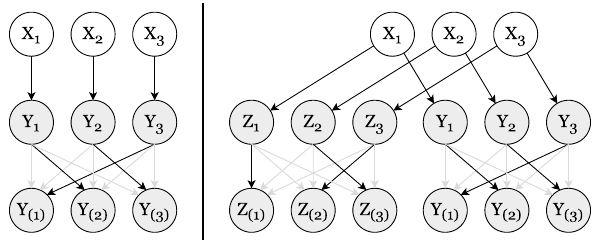
Fig. 4 Relationship between different quantities in a three-item gen- erative model. X n , Y n / Z n , and unranked noisy estimates, and the ranked noisy estimates of the items respectively for n , r , s ∈ { 1,2,3 } . (L) Under one estimation noise level, ∃ a bijection between X n and Z and ( s ) may be generated by the same